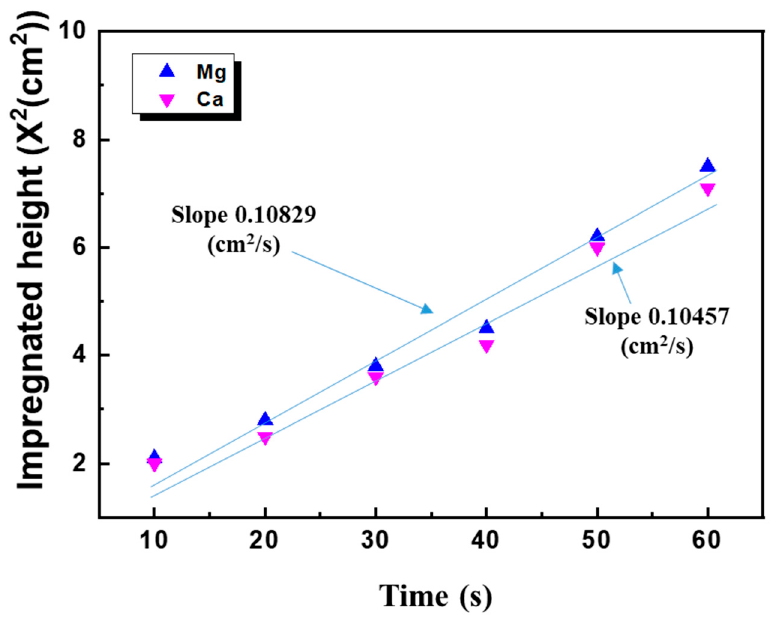
Figure 4. Penetrated distance squared of n-hexane infiltrating lubricant as a function of time.